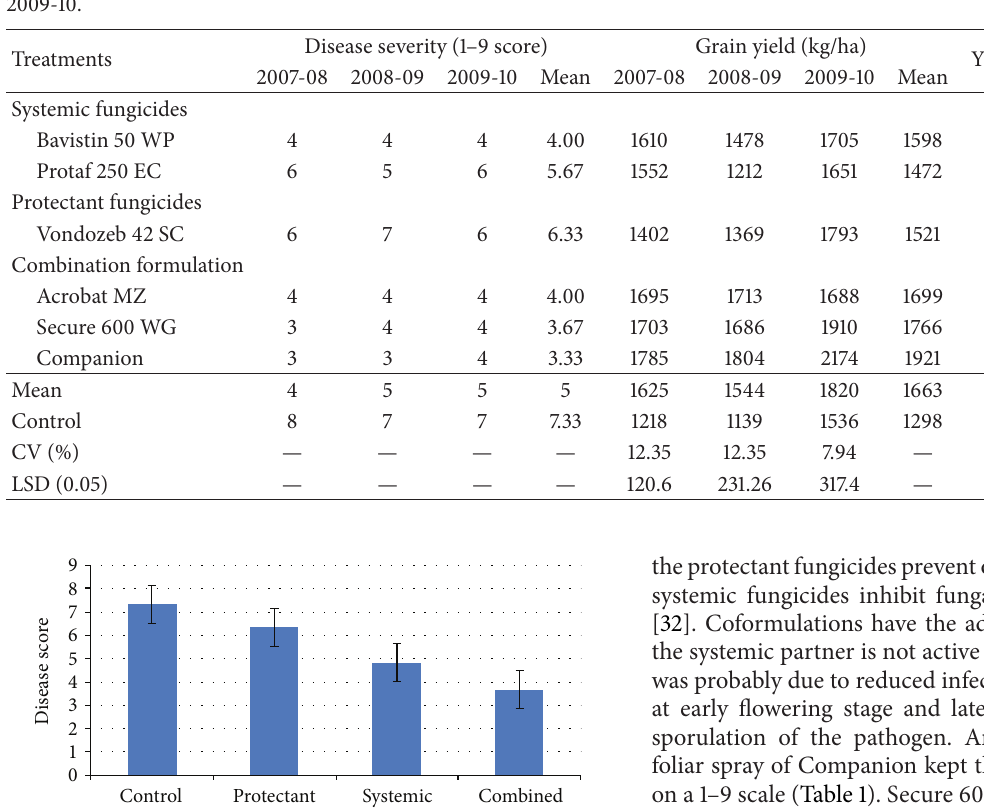
Table 1: Effect of foliar spray of fungicides with different modes of action on BGM disease severity and grain yield in BGM susceptible chickpea variety “BARIchhola-1” under field conditions at Madaripur in Bangladesh during postrainy seasons of 2007-08, 2008-09, and 2009-10.